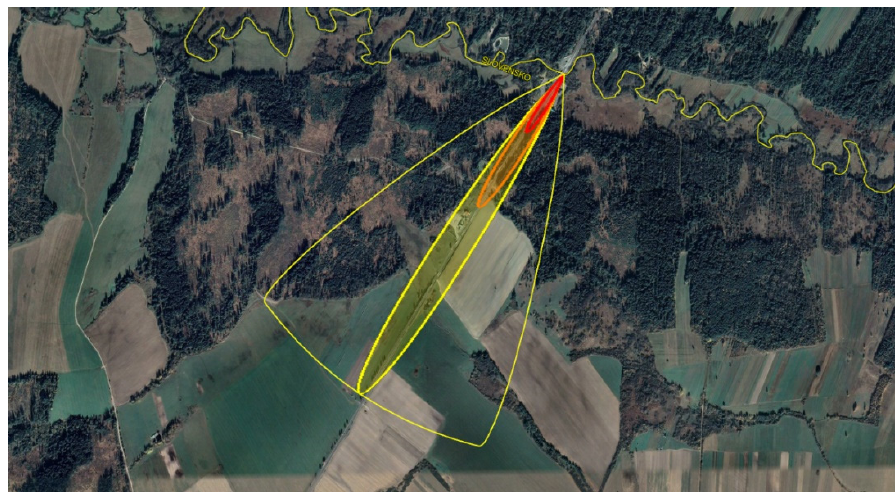
Figure 12. Graphical representation of the dispersion of a dangerous substance at the Trstená-Chyžné border crossing [24,25].